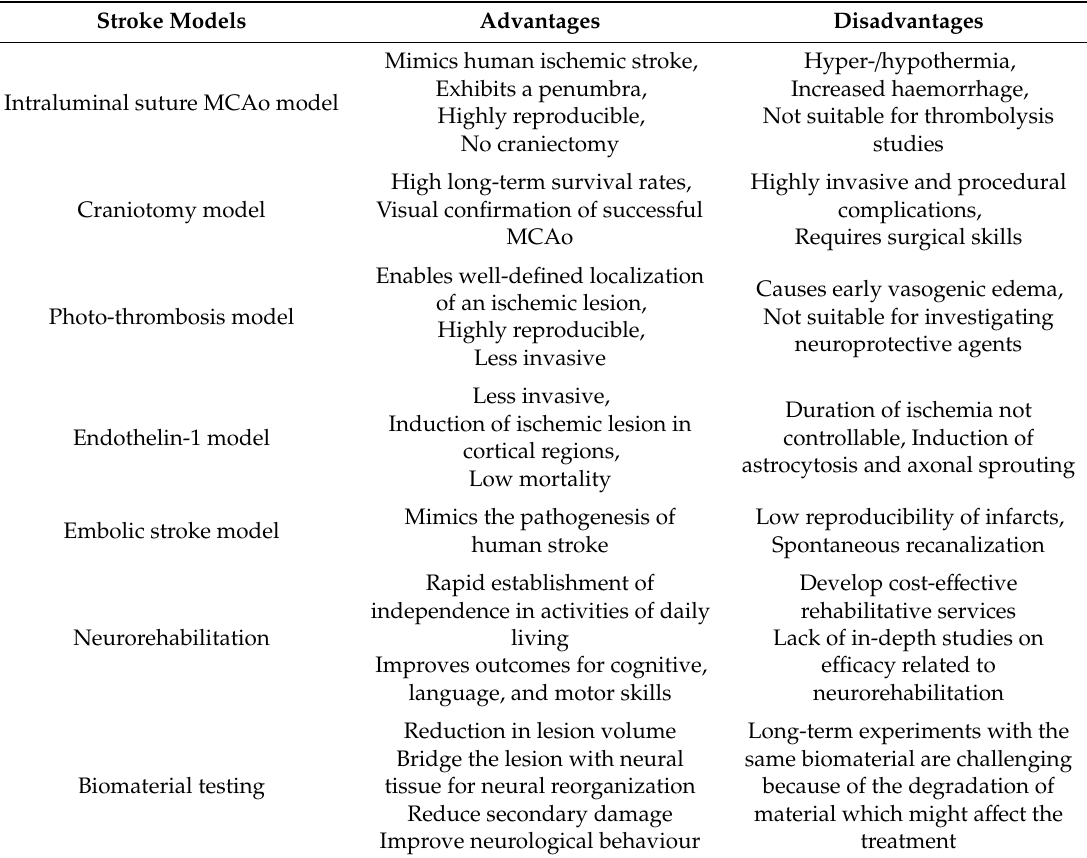
Table 1. Advantages and disadvantages of the stroke